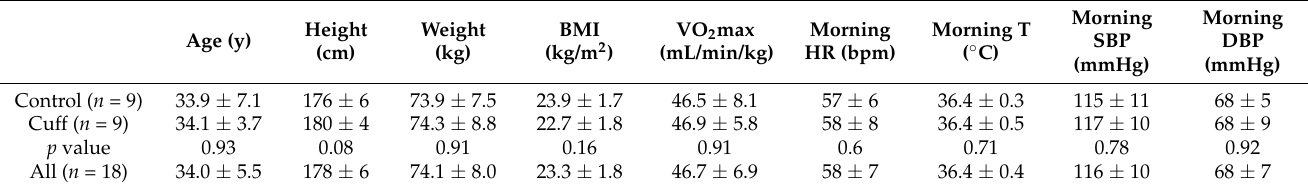
Table 1. Participant